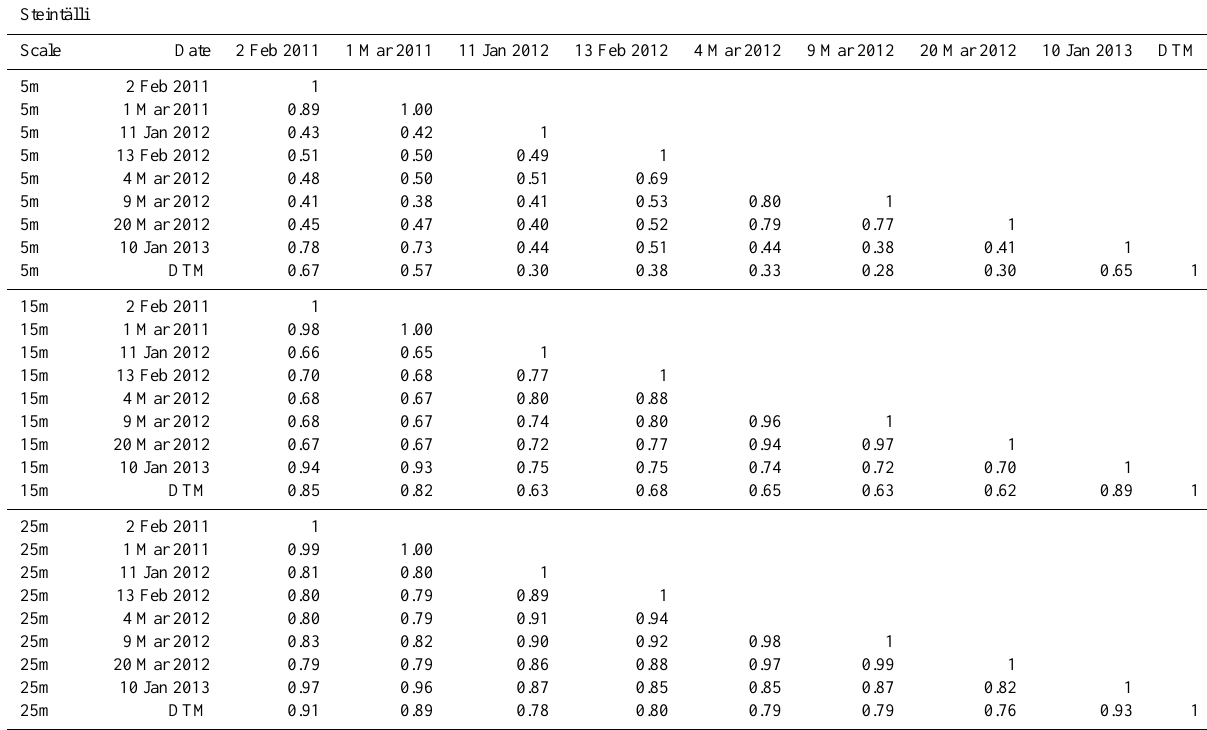
Table 6. Coefficient of determination ( R 2 ) of surface roughness correlations in the ST basin ( p < 0.0001). Steintälli Scale